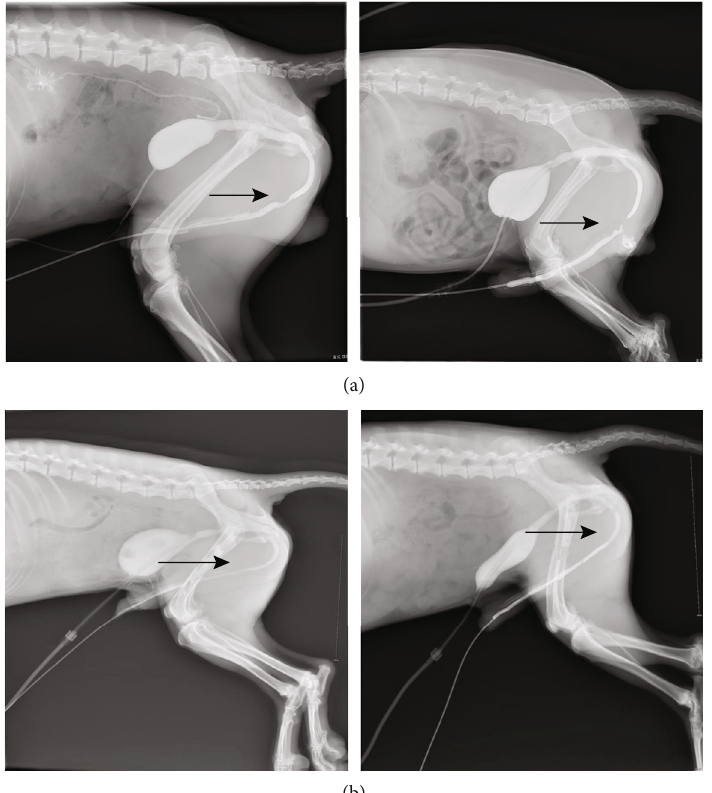
Figure 5: Postoperative urethrography. (a) Urethral stricture and urine leakage were con fi rmed in the control group. (b) Wide urethral calibers were demonstrated in the experimental group.